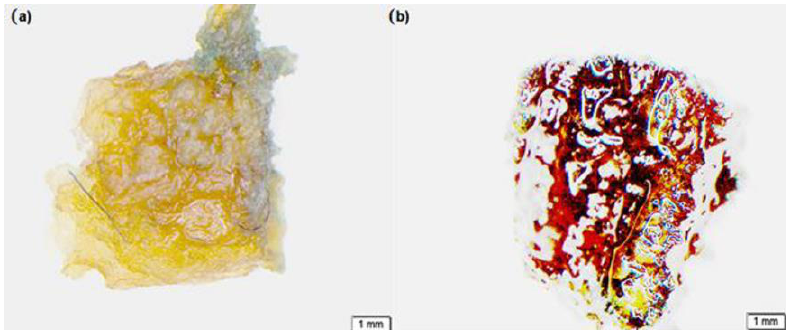
Figure 5. Images from Leica microsystem (Leica MZ10 F): ( a ) the scaffold without cells (control) and ( b ) the scaffold with cells, both treated with methylene blue.